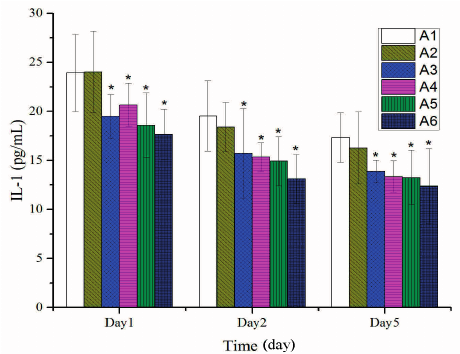
Figure 4. Effect of different concentration or fractions of BBO on plasma IL-1 in rats. Values are expressed as mean ± S.D. ( n = 4 animals). * : p < 0.05 vs. control.